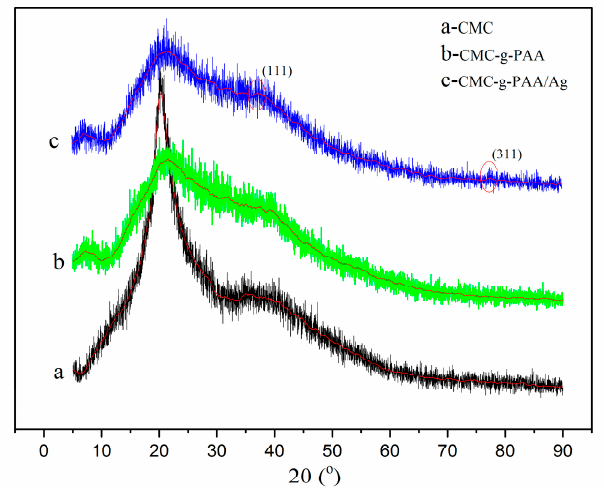
Figure 3. X-ray diffraction (XRD) patterns of CMC, CMC-g-PAA and CMC-g-PAA/Ag.